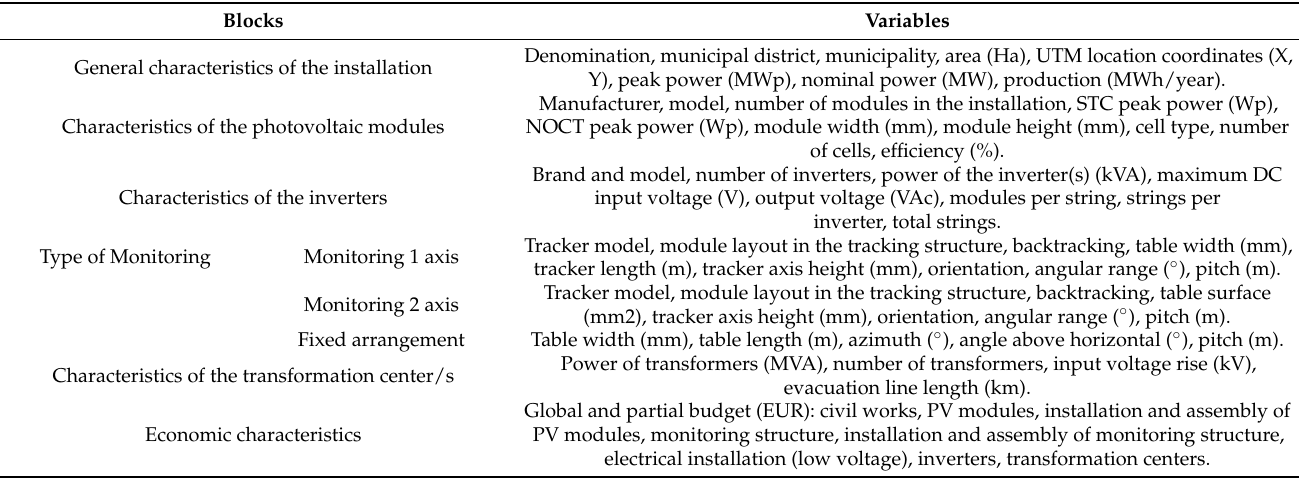
Table 1. Variables analyzed for each of the execution projects considered.